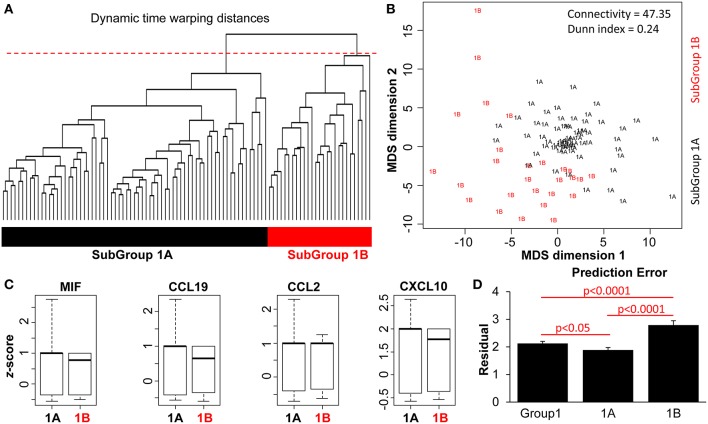
DTW clustering analysis as applied to patients in Group 1 (n = 101). (A) A dendrogram of the pairwise Euclidean distances of the patient pathology profiles in Group 1 (n = 101). An arbitrary cut-off of 90% height was applied to the dendrogram (red dashed line), to produce two patient subgroups (color bars). (B) Isotonic MDS plot of the Euclidean distances between the 101 patients, with Subgroup 1A (n = 69) and Subgroup 1B (n = 32), indicated by text and colors. Connectivity and Dunn index metrics (top right) indicate the quality of the clustering method. (C) Boxplot comparison between the two subgroups of patients based on z-normalized serum cytokine parameters. (D) Comparison of prediction error with and without subgrouping information. Bar plots represent results from LOPO multiple linear regression to predict the SLEDAI-2K of each patient visit based on the blood and urinary parameters, performed on all Group 1 patients vs. Subgroup 1A and 1B patients.